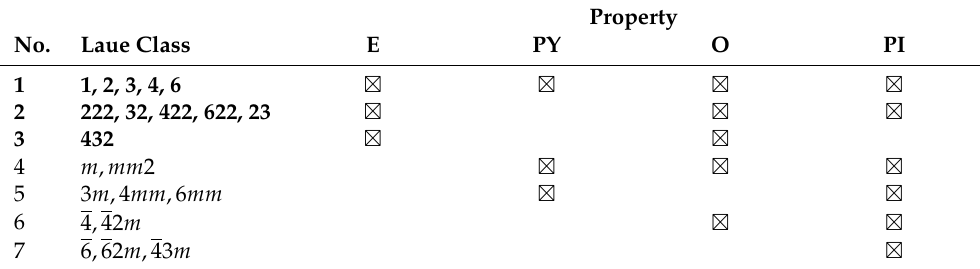
Table 1. Structure–symmetry–property relations in 7 non-centrosymmetric classes composed from the 21 non-centrosymmetric Laue classes.